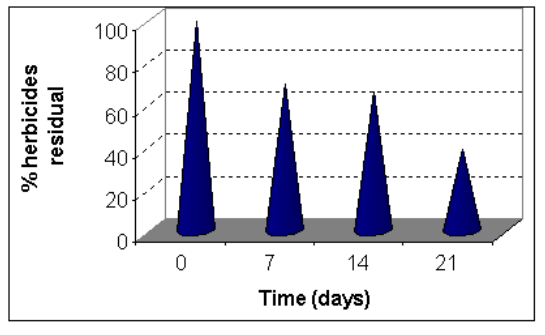
FIGURE 4. Biodegradation in PCB of metsulfuron-methyl (500 mg/l) by A. niger